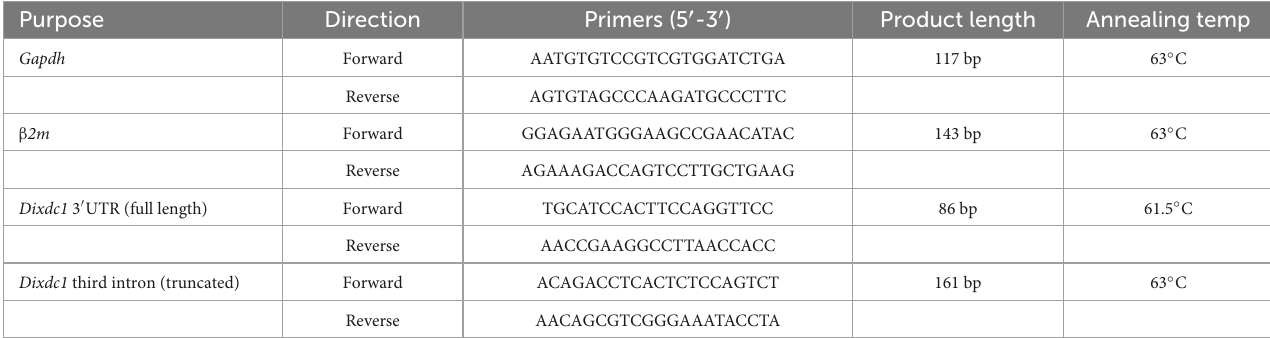
TABLE 3 Primers used for quantitative